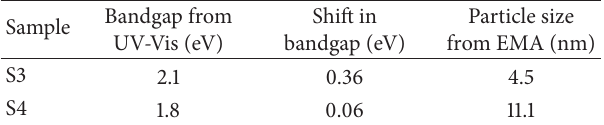
Figure 2: XRD of CdSe thin film (S4) prepared by thermolysis at 300 ∘ C. Table 1: Bandgap, shift in bandgap, and particle size calculated from absorption